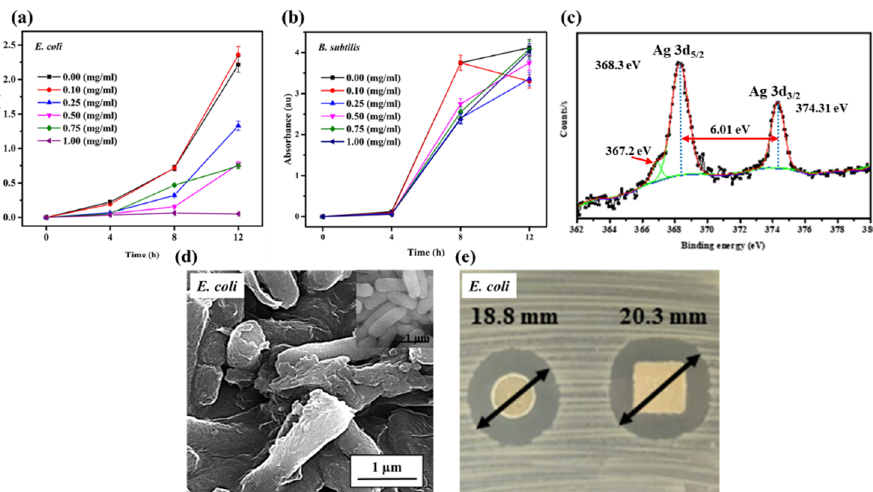
Figure 4. Investigation of the SiO 2 @Ag-based antibacterial agent: ( a , b ) Minimum inhibitory concentration (MIC) test against E. coli and B. subtilis ; ( c ) XPS analysis of Ag NPs after treatment for MIC test; ( d ) FE-SEM image of the decayed morphology of the E. coli bacteria. The inset is the untreated E. coli used for the comparison. The scale bar is 1 µ m; ( e ) Disk diffusion assay of SiO 2 @Ag coated on steel (round) and polyethylene (rectangular) versus E. coli.